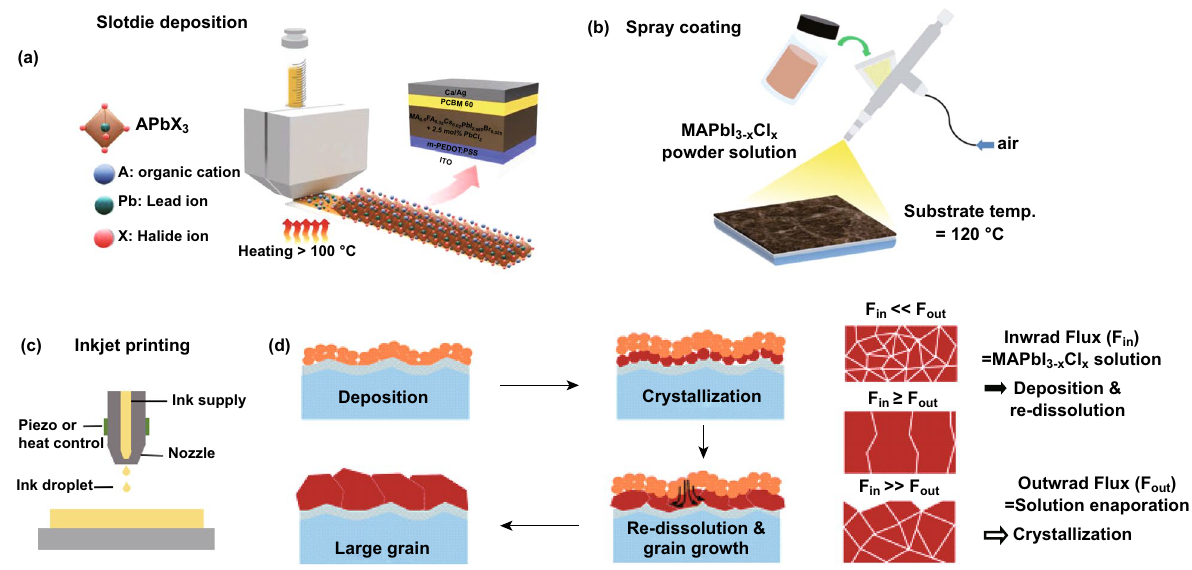
Fig. 9 Common scalable solution deposition methods. a Slot-die deposition [112]. Copyright © 2019 WILEY-VCH Verlag GmbH & Co. KGaA, Weinheim. b Spray coating [95]. c inkjet printing. d Crystalline grain growth and the morphology of the formed crystalline grains in the perovskite film with respect to the balance between F in and F out [95]. Copyright © 2016 The Royal Society of